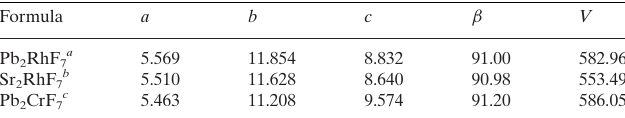
Comparison of the cell parameters of the three isostructural hepta- fluorides showing a noticeable anomaly on the c parameter of the chromium